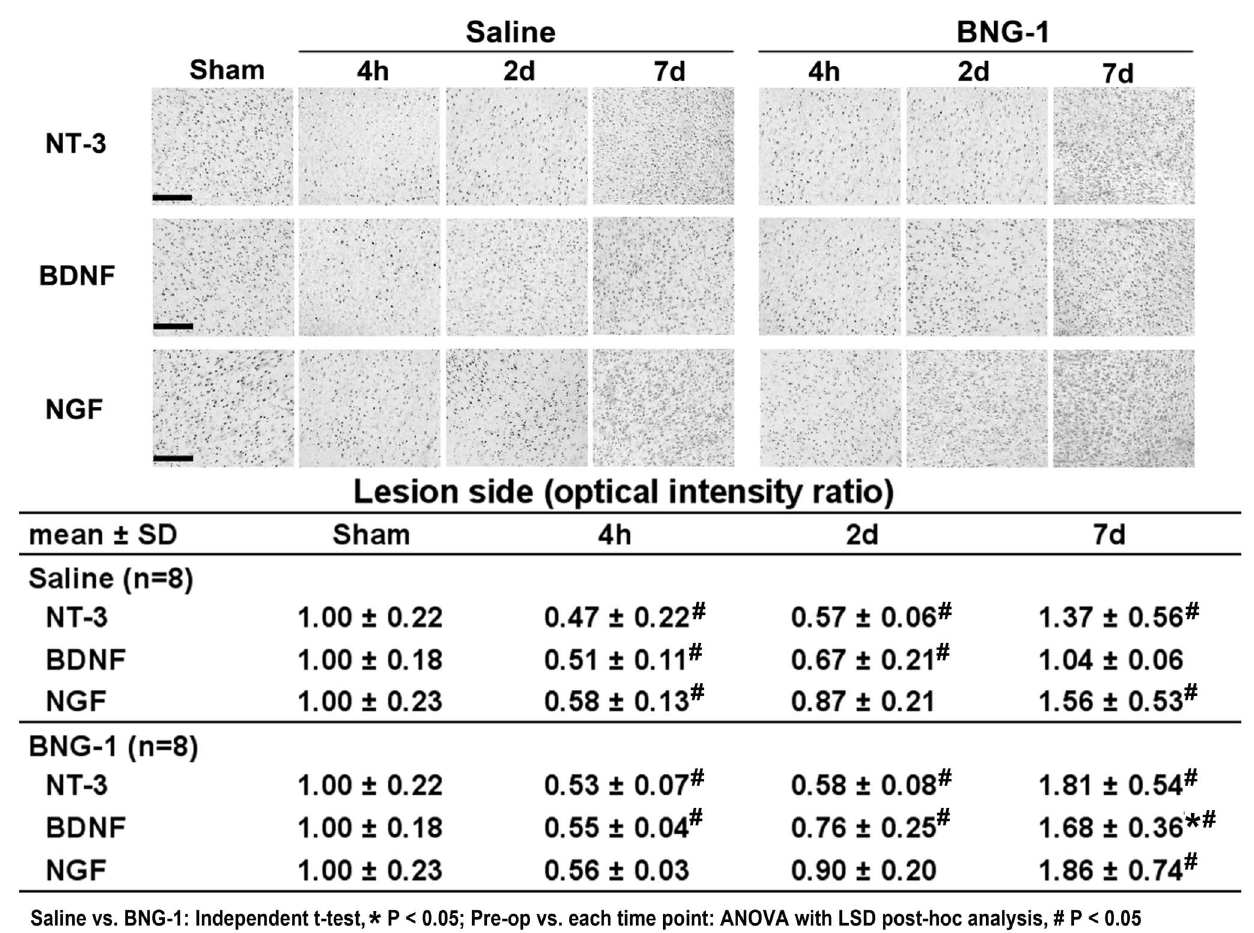
Fig. 5. Comparison of the temporal expression of neurotrophic factor immunoreactivity after focal cerebral ischemia between the saline and BNG- 1 treatments. The optical intensity of BDNF immunoreactivity on the lesion cortex is higher in the BNG-1 group than the saline group at 7 d, whereas no difference in NT-3 and NGF levels occurred at any time point. The bar in the sham panels indicates 100 m m.